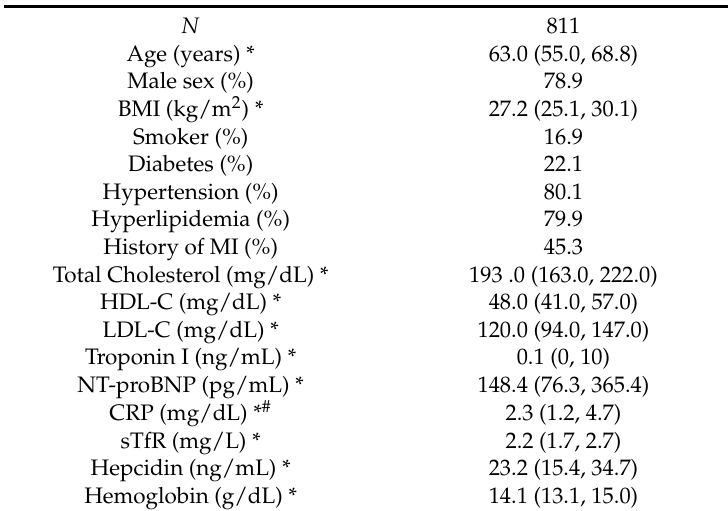
Table 1. Baseline characteristics of the study patients.